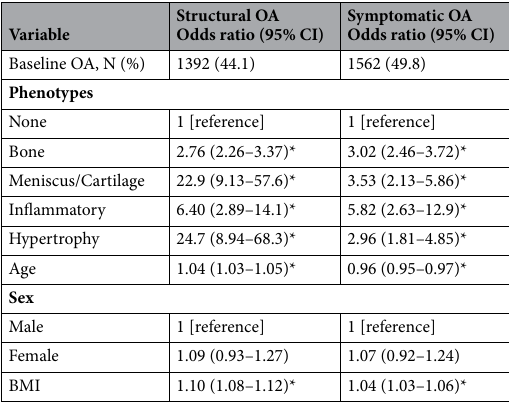
Table 2. Logistic regression models of cross-sectional structural and symptomatic OA (N = 3154). Both models were adjusted for age, sex, and BMI by adding these variables as predictors in the regression models. “-”: not applicable, OA: osteoarthritis, CI: confidence interval, BMI: body mass index. *: Statistically significant at P value < 0.05.